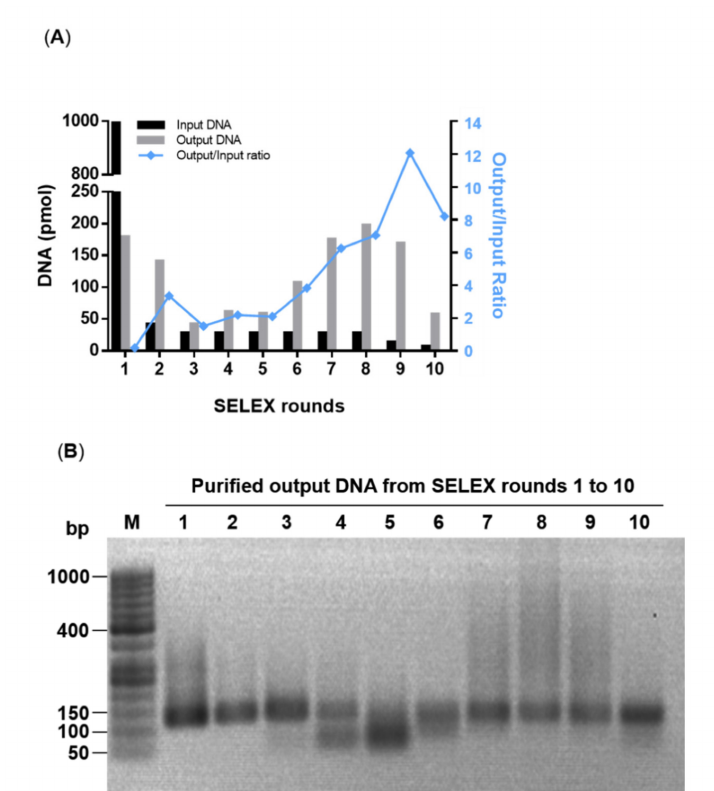
Figure 4. Enrichment of putative aptamers against the RBSDV His-P10 protein in SELEX. ( A ) The amount (pmol) of input DNA and output DNA in SELEX rounds 1 to 10 were plotted on the left Y -axis (as a bar graph); the DNA output / input ratio was plotted on the right Y -axis (as a line graph in blue color). ( B ) Purified output DNA from SELEX rounds 1 to 10 were separated by 2% agarose gel electrophoresis and stained by ethidium bromide (0.5 µ g / mL).